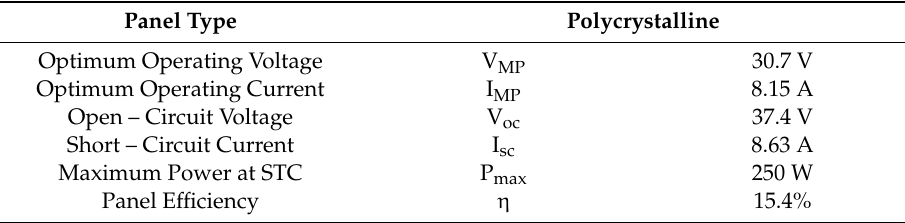
Table 2. Electrical characteristic parameters of a PV panel.